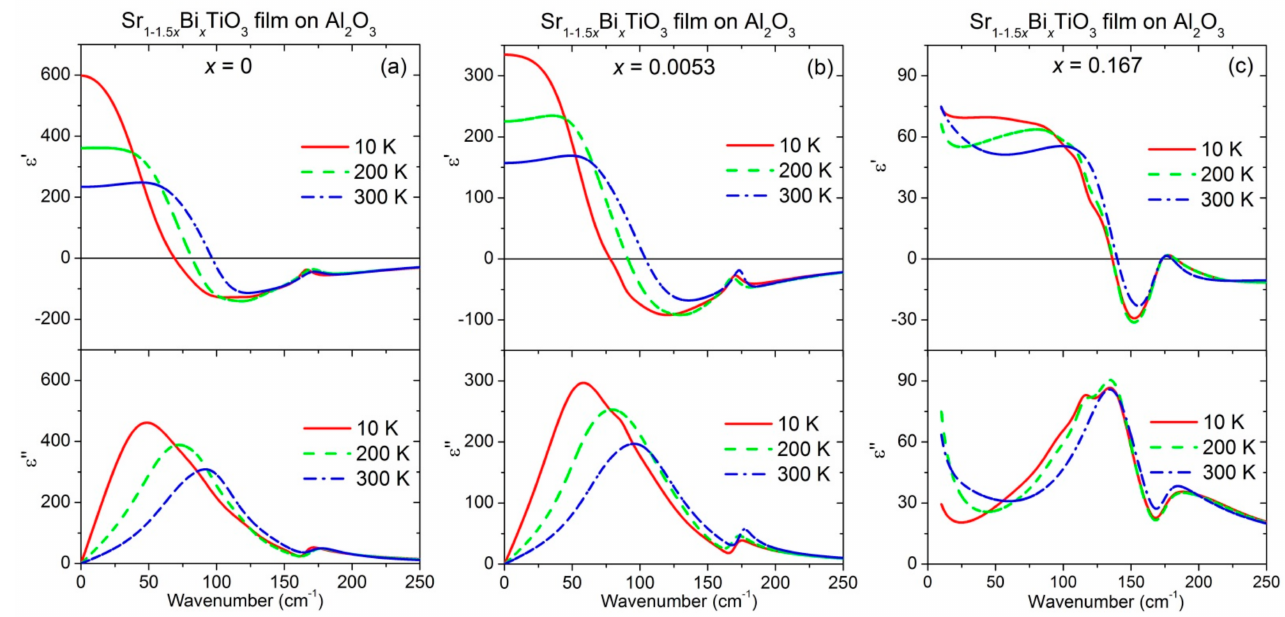
Figure 4. Spectra of the real ε (cid:48) (top panel) and imaginary ε ” (bottom panel) parts of the dielectric permittivity in the infrared range, obtained from the transmittance fits at 10 K (solid lines), 200 K (dash lines) and 300 K (dash-dot lines) for Sr 1 − 1.5x Bi x TiO 3 thin films with x = 0 ( a ), 0.0053 ( b ) and 0.167 ( c ) deposited on Al 2 O 3